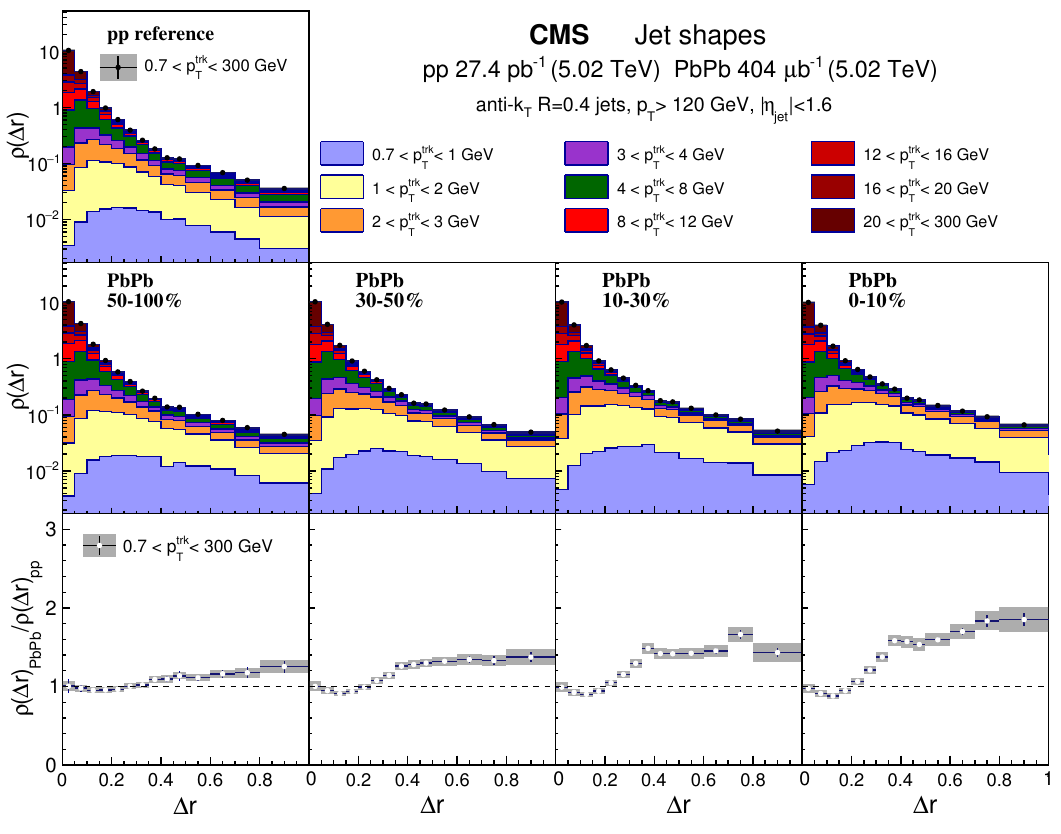
Figure 6 . The jet shape (cid:26) ((cid:1)r) in pp (top left) and PbPb (middle row) collisions. The PbPb results are shown for di(cid:11)erent centrality regions. The bottom row shows the ratio between the PbPb and pp data for the inclusive range 0 : 7 < p trk < 300 GeV. The shaded band in the ratio plots shows the T total systematic